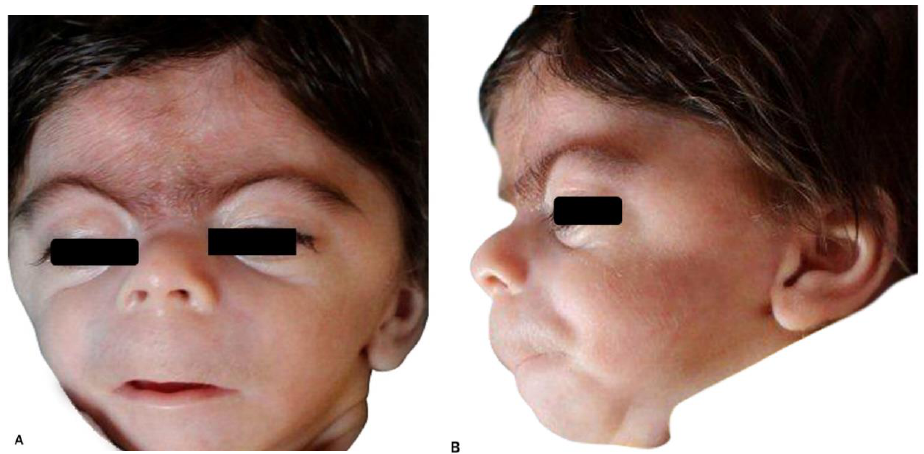
Figure 1. Ultrasound examination of the fetal face in a CDLS case with classical phenotype: ( A ) 2D image of the fetal profile at 29w of gestation, showing mild micrognathia/retrognathia; abnormal philtrum; depressed nasal bridge; ( B ) Volume reconstruction of the fetal face at 29 w of gestation; ( C ) Volume reconstruction of the fetal face at 34w of gestation.